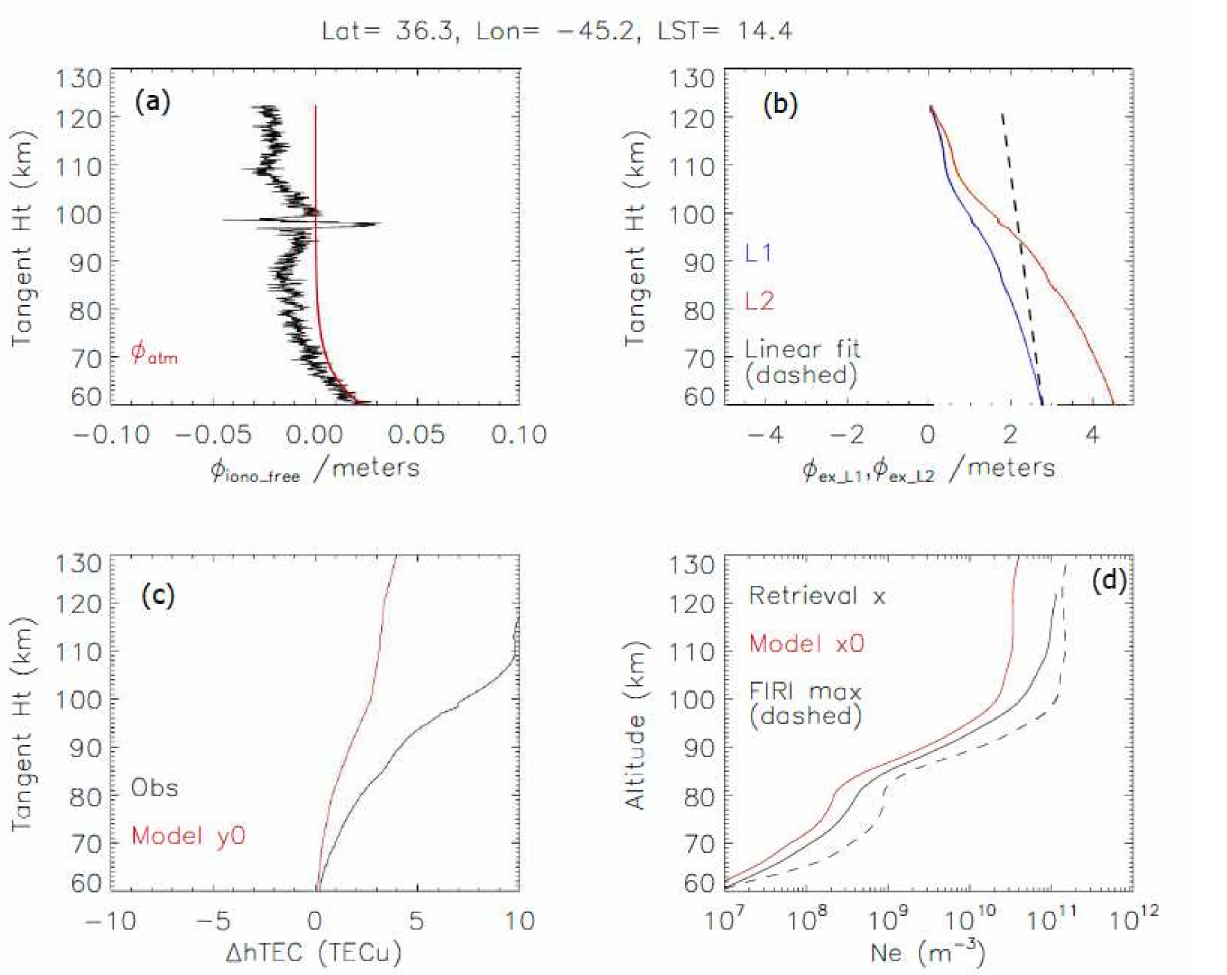
are inverted to produce a new 0